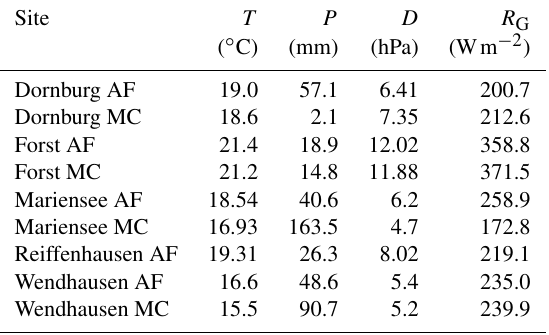
Table 3. Mean air temperature ( T ; ◦ C), vapour pressure deficit ( D ; hPa), global radiation ( R G ; Wm − 2 ), and the cumulative precipita- tion ( P ; mmd − 1 ) for the respective site and campaign period. Data for Reiffenhausen MC are missing due to the unavailability of a